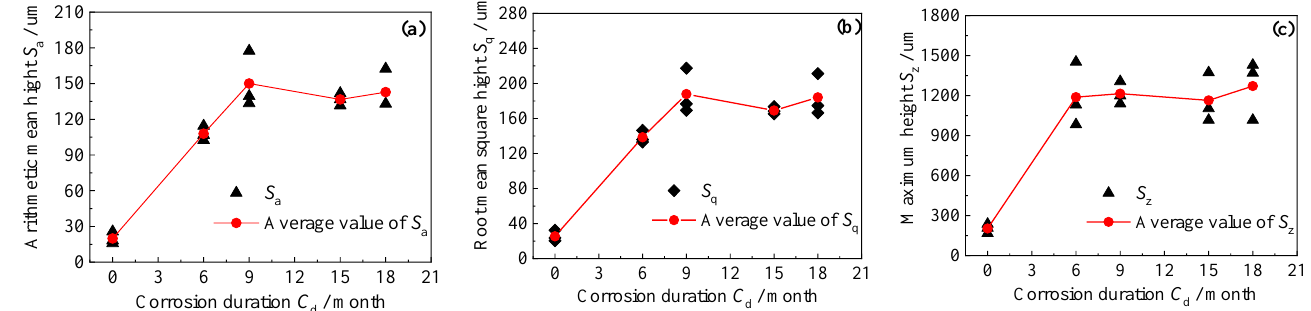
Figure 5. Effect of corrosion duration on the 3D roughness parameters: ( a ) arithmetic mean height S a , ( b ) root mean square height S q , and ( c ) maximum height S z .